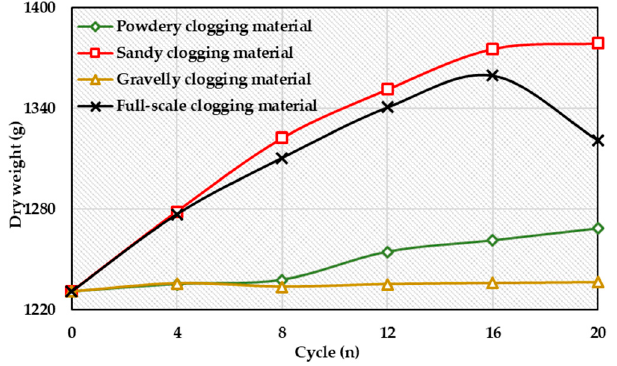
ff erent clogging materials.